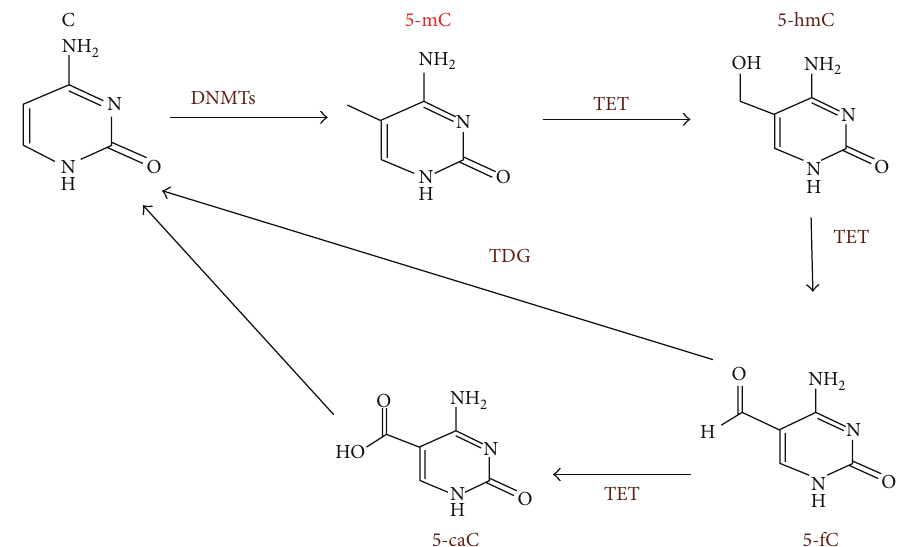
Figure 1: Base methylation at DNA levels. Cytosine (C) is methylated to methylcytosine (5-mC) by methyltransferases (DNMTs), and the 5- mC is oxidized or hydroxylated by ten-eleven translocation proteins (TETs) to 5-hydroxymethylcytosine (5-hmC). And the 5-hmC is believed to be mediator for demethylation 5-mC to C through serial steps: 5-mC is further oxidized by TETs to generate 5-formal C (5-fC) and 5- carboxy-C (5-caC), and finally 5-fC and 5-caC are converted to regular C catalyzed by thymidine DNA glycosylase (TDG). Methylation of adenosine at 6 position (6mA) has been also detected in the genomes of mammalian, Chlamydomonas , Drosophila , and C. elegance cells. TETs or TET analogues are responsible for generation of the